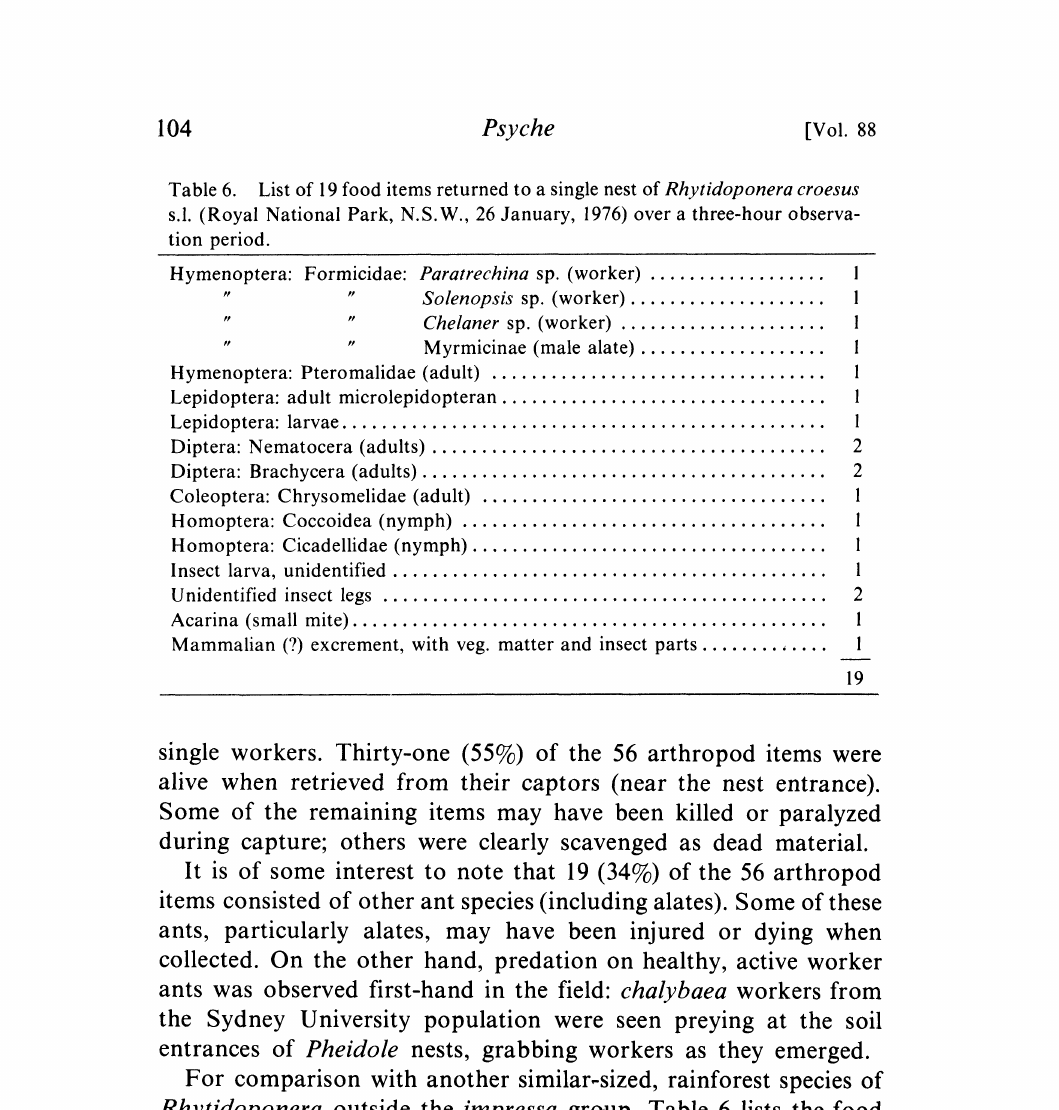
Table 6. List of 19 food items returned to a single nest of Rhytidoponera croesus s.1. (Royal National Park, N.S.W., 26 January, 1976) over a three-hour observa- tion period. Hymenoptera: Formicidae: Paratrechina sp. (worker) Solenopsis sp. (worker) Chelaner sp. (worker) Myrmicinae (male alate) Hymenoptera: Pteromalidae (adult) Lepidoptera: adult microlepidopteran Lepidoptera: